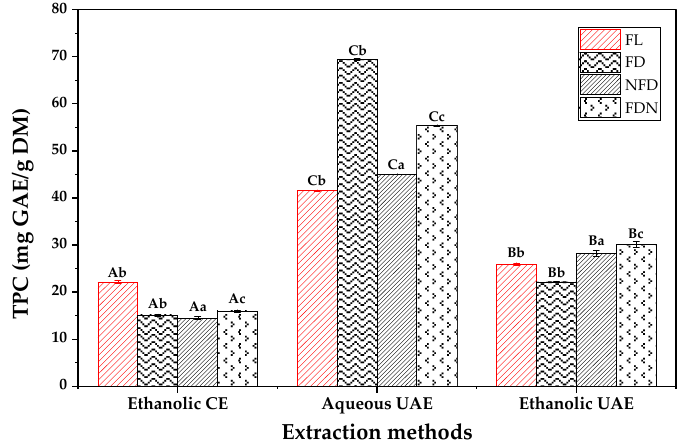
Figure 4. Total phenolic content (TPC) of phenolic extracts obtained from SBLs. Data are presented as mean ± SD ( n = 3). Different capital letters indicate significant differences in the extraction method, and different small letters show significant differences in the sample preparation method ( p ≤ 0.05), according to two ‐ way ANOVA and Tukey’s HSD test.